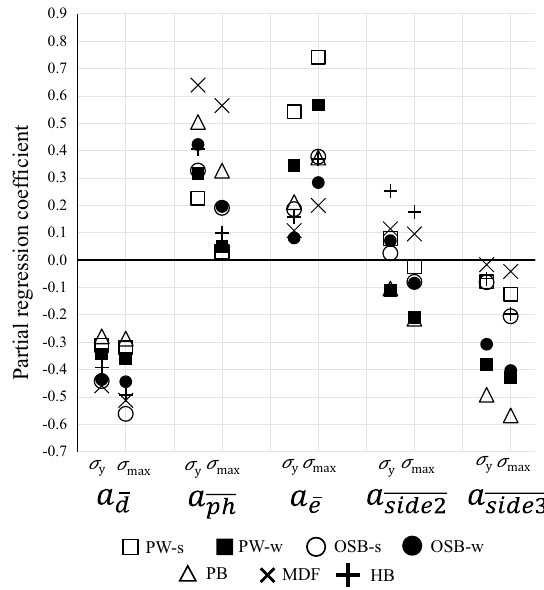
Bold number indicates that the p value is under 0.05. σ y and σ max mean the yield stress and the maximum stress, respectively